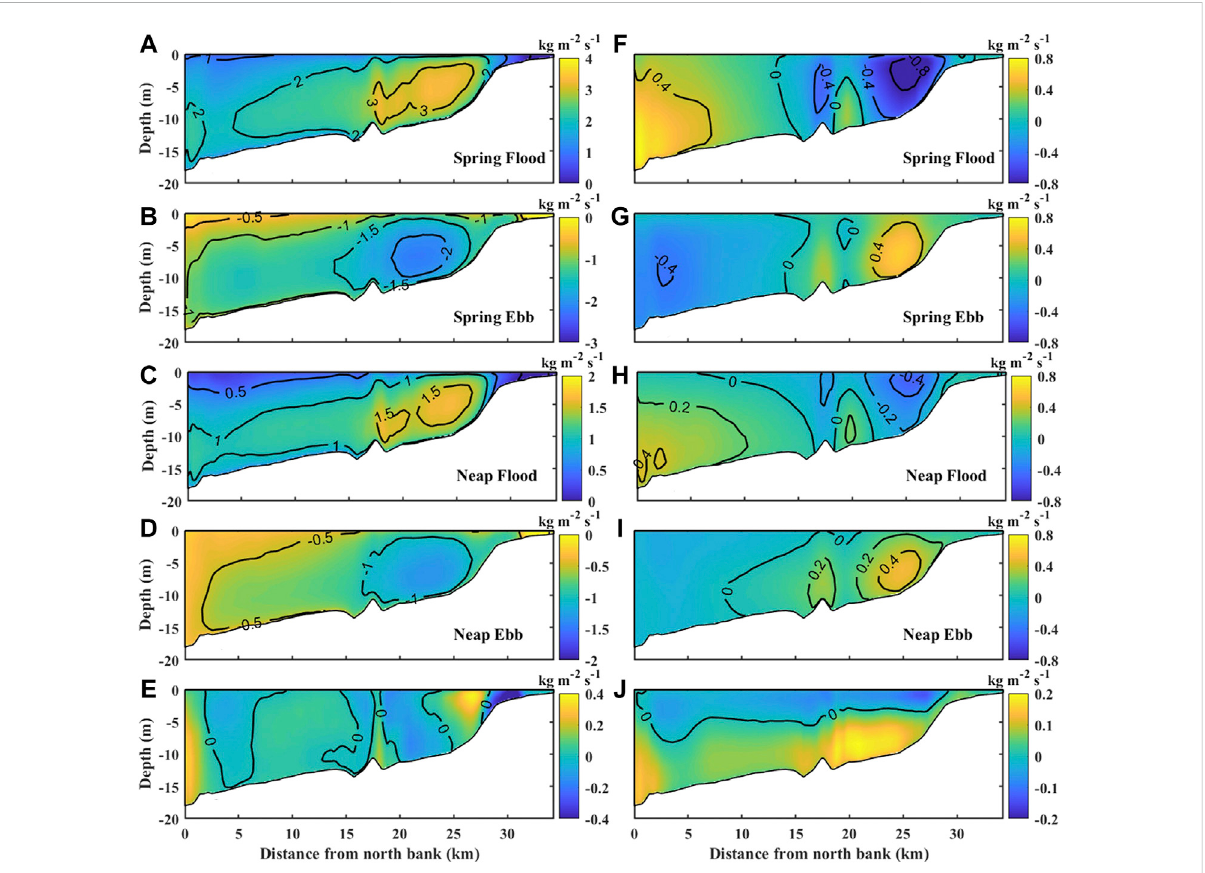
FIGURE 5 The distribution of sediment fl uxintheC1section during thespring- fl oodtide (A) along-estuarine and (F) lateral. (B,G) , (C,H) , (D,I) are thesame as (A,F) , and the times are for spring-ebb tide, neap- fl ood tide, and neap-ebb tide, respectively. (E,J) are the averaged along-estuarine and lateral sediment fl uxes in 1 month, respectively. Positive values indicate landward or southern